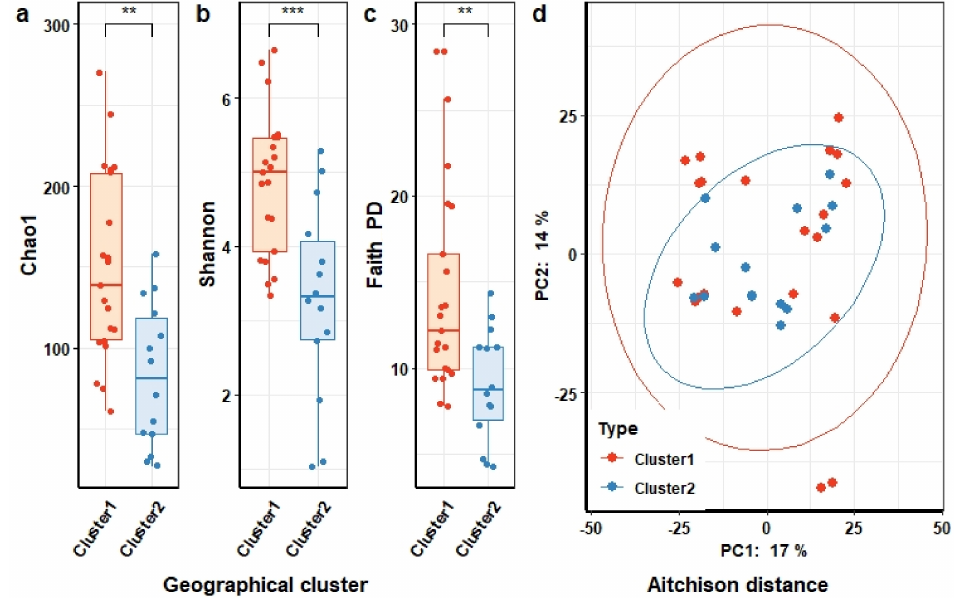
Figure 4. Microbial richness, diversity, and community structure of domestic animal gut microbiota (both chickens and dogs) living in different geographical clusters. Differences in the microbial richness (Chao1 ( a )) and diversity (Shannon ( b ) and Faith’s PD ( c )) between animals living in cluster 1 versus animals living in cluster 2 compared by Wilcoxon test. Difference is significant at FDR q -value < 5 × 10 − 2 . ( d ) Ordination of the gut microbiota community structures of geographical cluster based on principal component analysis of Aitchison distance. Each point represents the gut microbial community structure of an individual animal and is colored according to geographic cluster with animals from cluster 1 colored in red and animals from cluster 2 colored in blue. (PERMANOVA test, FDR q -value ≥ 5 × 10 − 2 for geographic cluster). Symbols show the statistical significance levels, ** indicates p < 1 × 10 − 2 , *** indicates p < 1 × 10 − 3